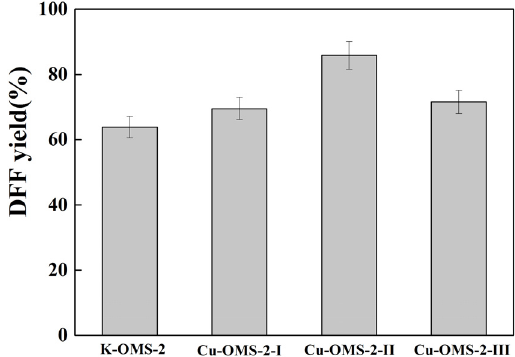
Figure 9. DFF yield under the catalysis of Amberlyst 15 and Cu-K-OMS-2. Reaction time and temperature were 12 h and 160 °C, respectively.